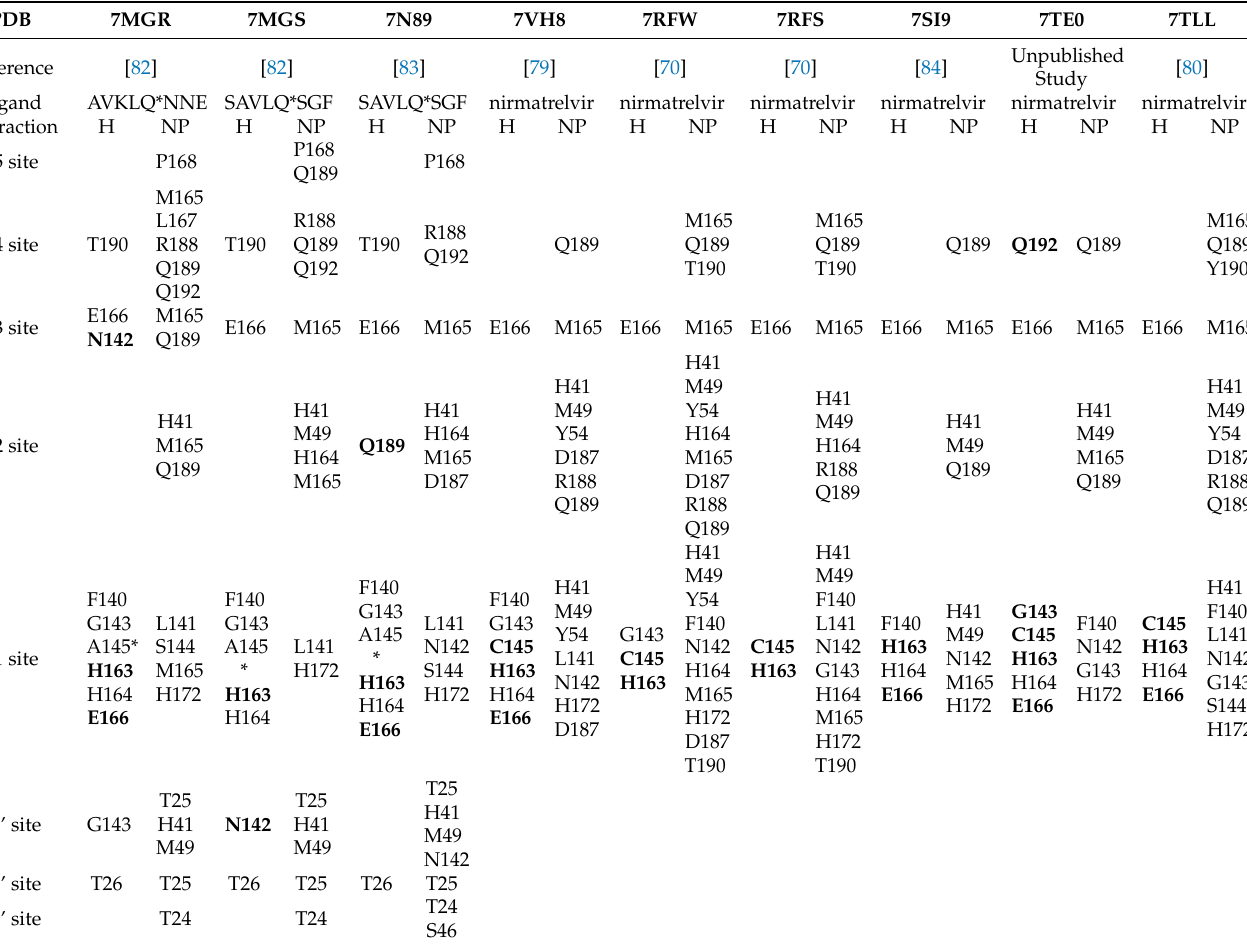
Table 1. Substrate and inhibitor-binding interactions at the active site of SARS-CoV-2 Mpro. The enzyme-ligand interactions were mapped using LigPlot+ v2.2.4 [63] and based on data available in PDBsum database [62]. H-bonds (H) and non-polar interactions (NP) are also shown. The interactions that are mediated by the side chains of enzyme residues are bold, and asterisk indicates modified catalytic residue (C145A) in the enzyme-substrate complexes. The graphical representation of the interactions is shown in Figure